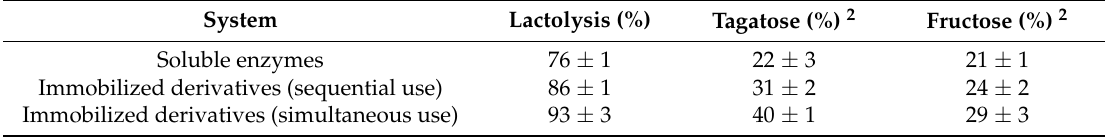
Table 5. Lactolysis and isomerization in Mozzarella cheese whey at 50 °C by tri-enzymatic systems 1 . System